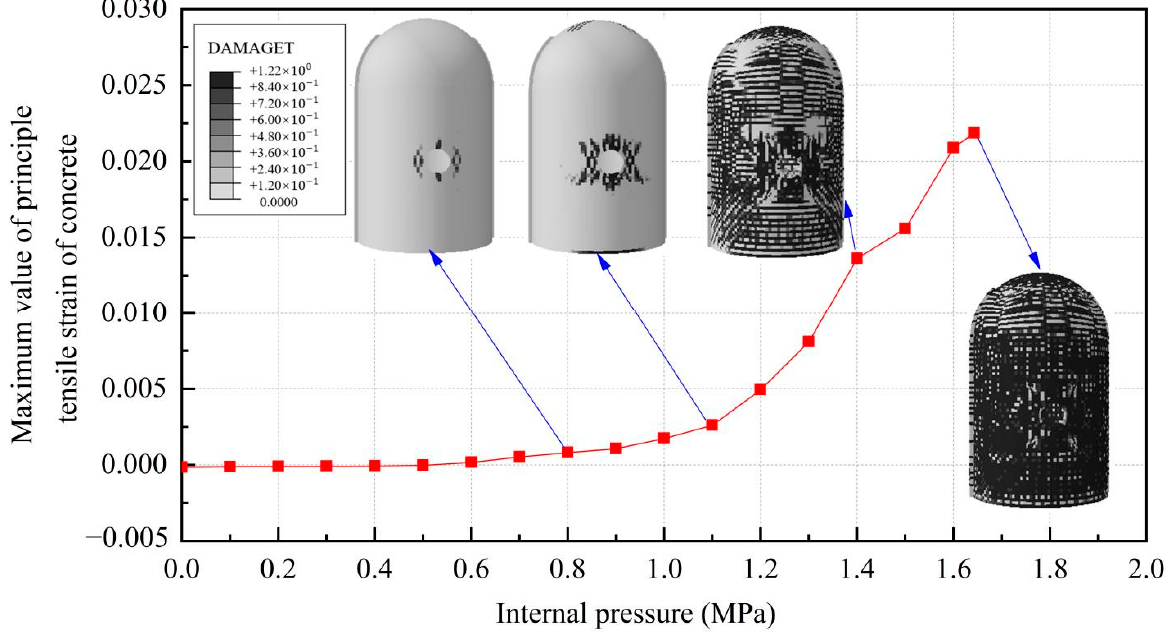
Figure 11. The evolution of cracks and principal tensile strain in